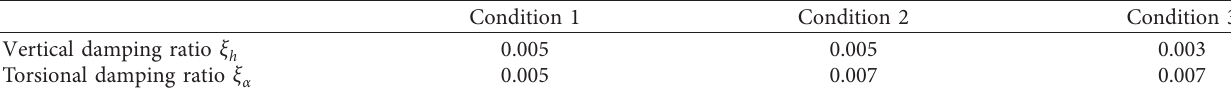
Table 3: Values of the damping ratio in three